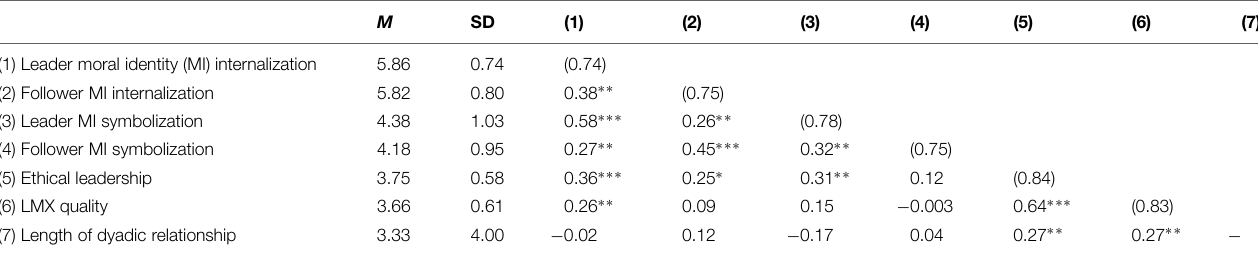
TABLE 1 | Means, SD, Cronbach’s alpha (in correlation matrix diagonal) and correlations of the variables.